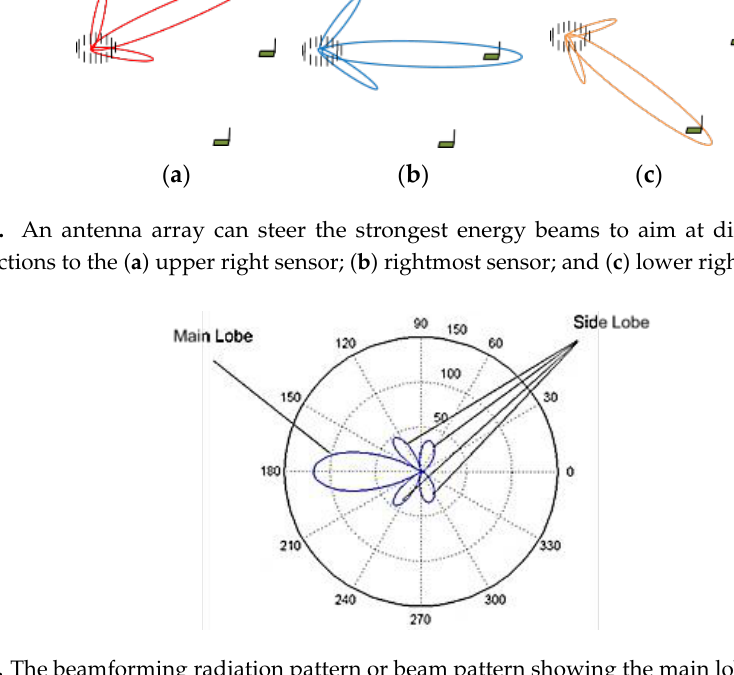
Figure 2. The beamforming radiation pattern or beam pattern showing the main lobe and side lobes.